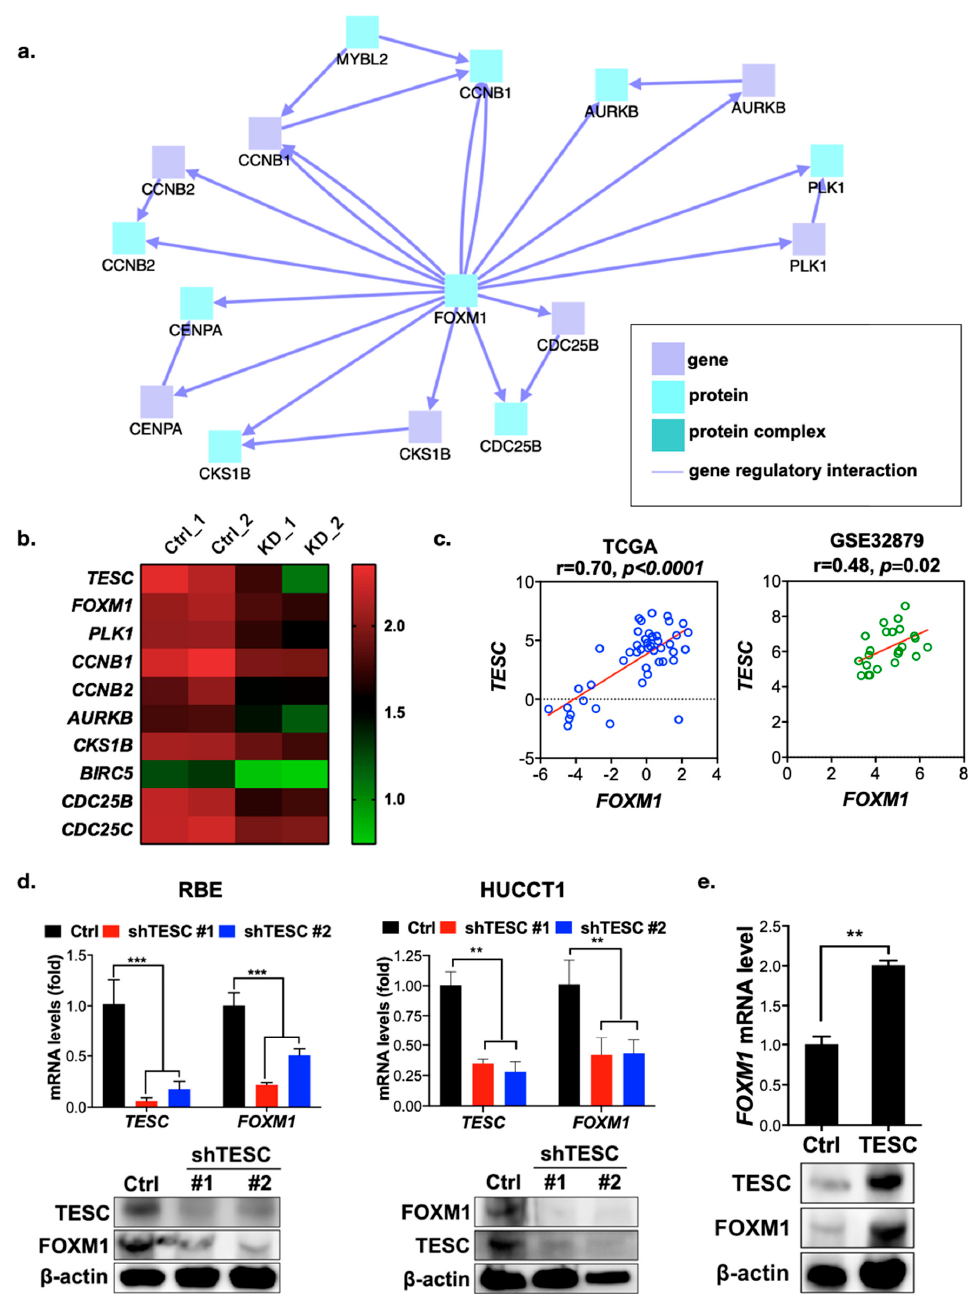
Figure 4. TESC regulates FOXM1 and its downstream genes. ( a ) Network analysis of di ff erentially downregulated genes in TESC-silenced cells. ( b ) Heat map representing expression levels of FOXM1 and its downstream genes in RBE cells infected with lentiviral vectors encoding shTESC (KD) or lentiviral vectors control (Ctrl). Ctrl_1 and Ctrl_2 indicate di ff erent shRNAs that target scrambled and luciferase, respectively. KD_1 and KD_2 indicate distinct shRNAs that target di ff erent regions within TESC . ( c ) Dot-plot analysis of co-expression between TESC and FOXM1 in cholangiocarcinoma from the TCGA (left) and GSE32879 (right) databases. ( d ) qPCR (upper) and immunoblotting (bottom) analysis of the e ff ect of TESC silencing on FOXM1 expression in RBE (left) and HUCCT1 (right) cells infected with lentiviral vectors encoding shTESC or scrambled control (Ctrl). ** p < 0.01, *** p < 0.001. ( e ) qPCR (upper) and immunoblotting (bottom) analysis of the e ff ect of TESC overexpression on FOXM1 expression in HUCCT1 cells infected with lentiviral vectors encoding TESC cDNA or empty control vector (Ctrl). ** p <